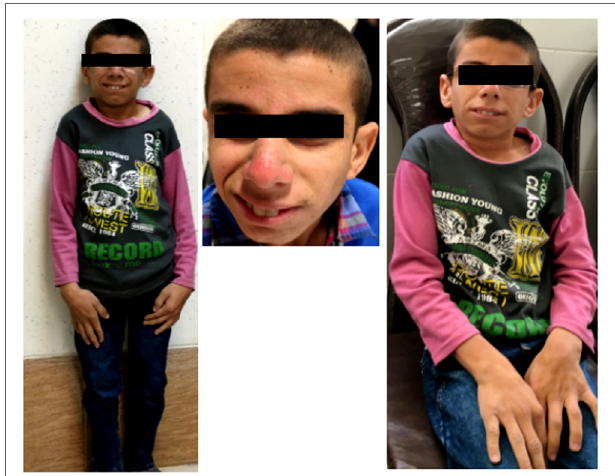
FIGURe 1 | Clinical presentation; proband is 16 years old boy with poor general growth, short stature postnatal microcephaly, lean cachectic face, and disproportionately large hands and ears. Inset images show large hand and evidences of cutaneous